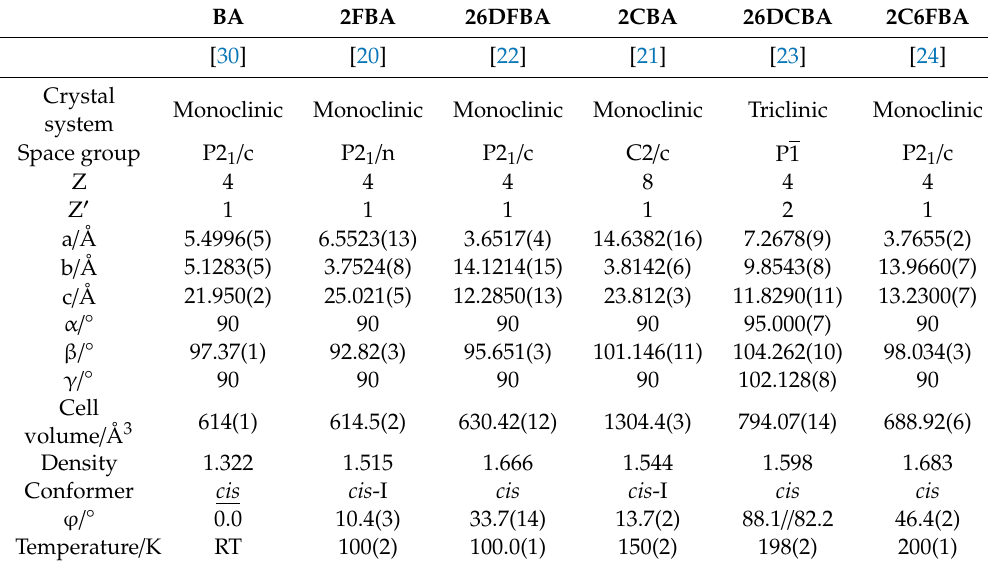
Table 8. Summary of the data for the crystals of the studied compounds a . BA 2FBA 26DFBA